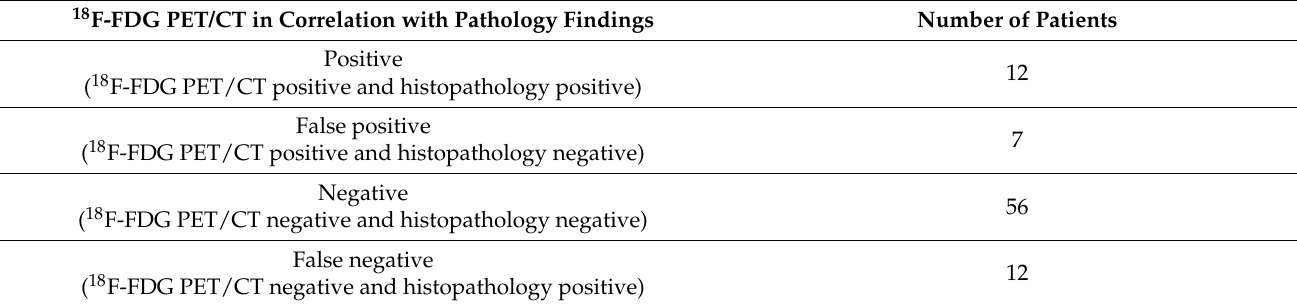
Table 10. Detection of LNM by